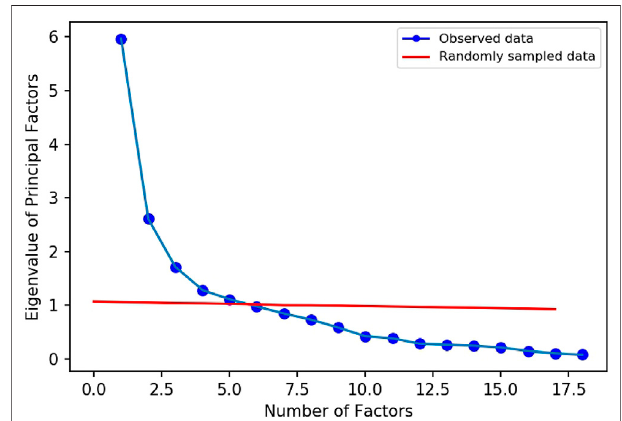
FIGURE 6 | Scree plot of eigenvalues for selecting an optimum number of factors for the exploratory factor analysis. The analysis utilizes a null-model based randomization to propose a parsimonious formulation of the full EFA model. Five factors were used for all subsequent analyses.